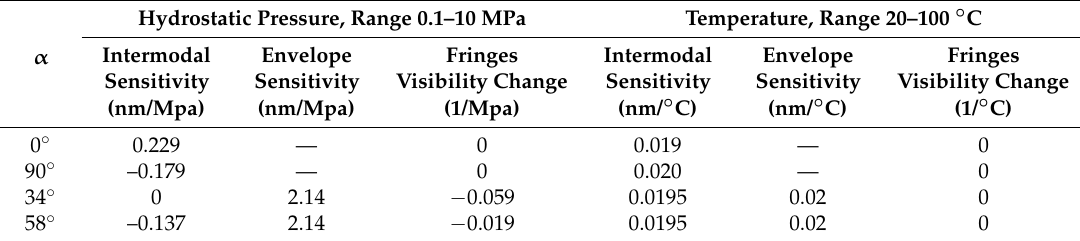
Table 1. Measured values of the sensitivities to temperature and pressure for different azimuths of the input polarization